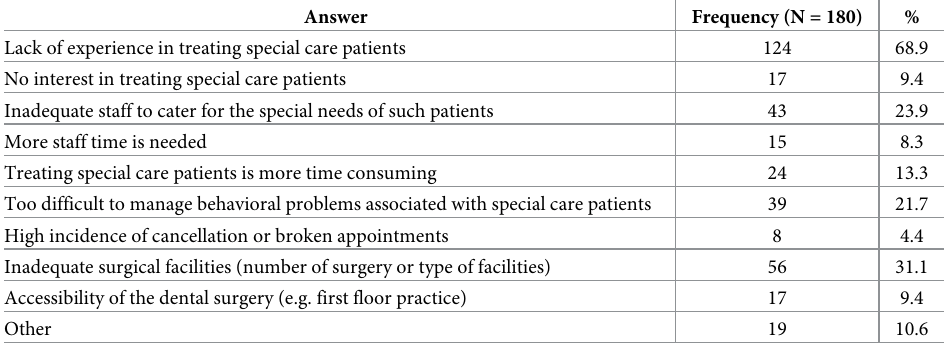
Table 2. Distribution of reason for not practicing SCD.